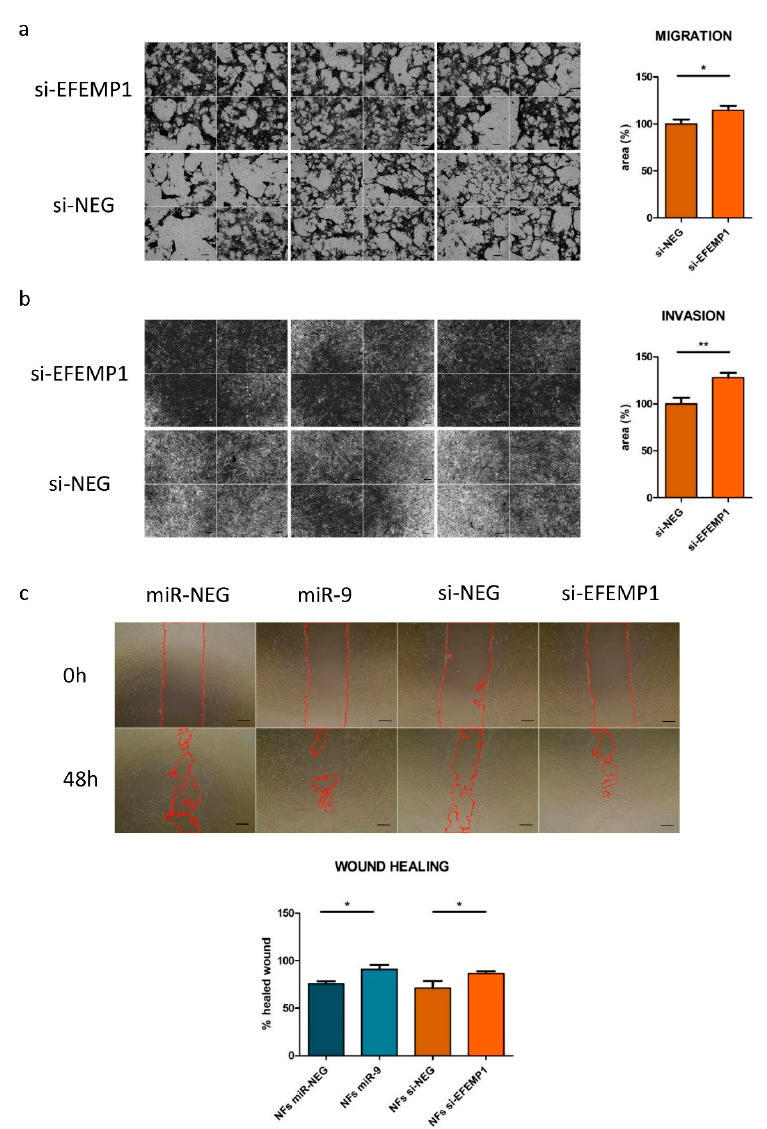
Figure 3. EFEMP1 silencing increases fibroblast’s motility. Migration ( a ), invasion ( b ) and wound healing ( c ) assays performed on fibroblasts transfected with miR-9 (wound healing exclusively) / si- EFEMP1 or controls. In Figure 3c, the red line identifies the region of the wound which is still not occupied by cells. Images are representative and data are presented as mean of three biological replicates ± SEM. (* p < 0.05; ** p < 0.01); scale bars, 100 μ m.